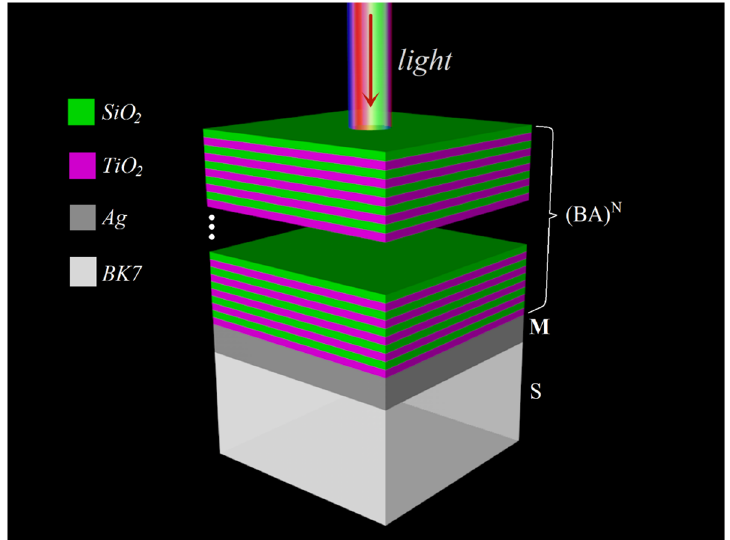
Figure 2. Schematic of the (BA) N MS structure. B represents the SiO 2 layers with n B = 1.431. A represents the TiO 2 layers with n A = 2.123. M denotes the thick Ag metal layer. S is substrate BK7 with n S =